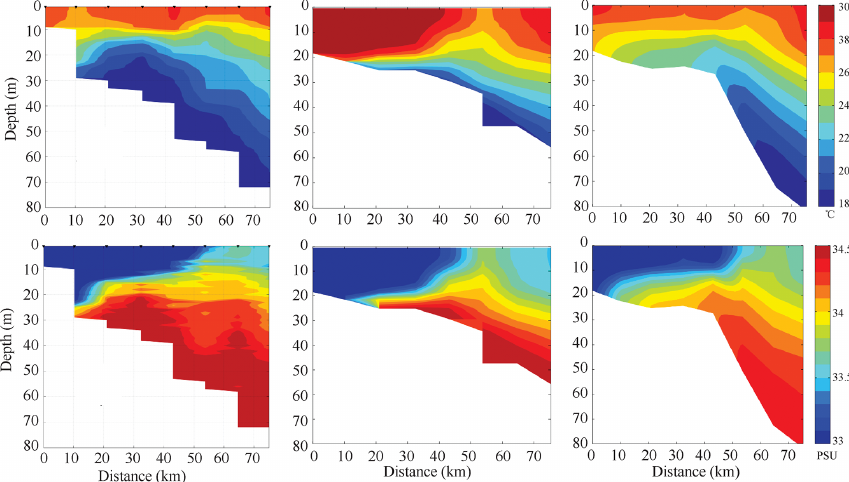
Figure 6. The vertical distributions of temperature (upper panels) and salinity (lower panels) along section E (see Fig. 1) from the in situ observations of Qiongdong cruise (left column), Mercator Océan (middle column), and SCSOFS (right column), respectively.